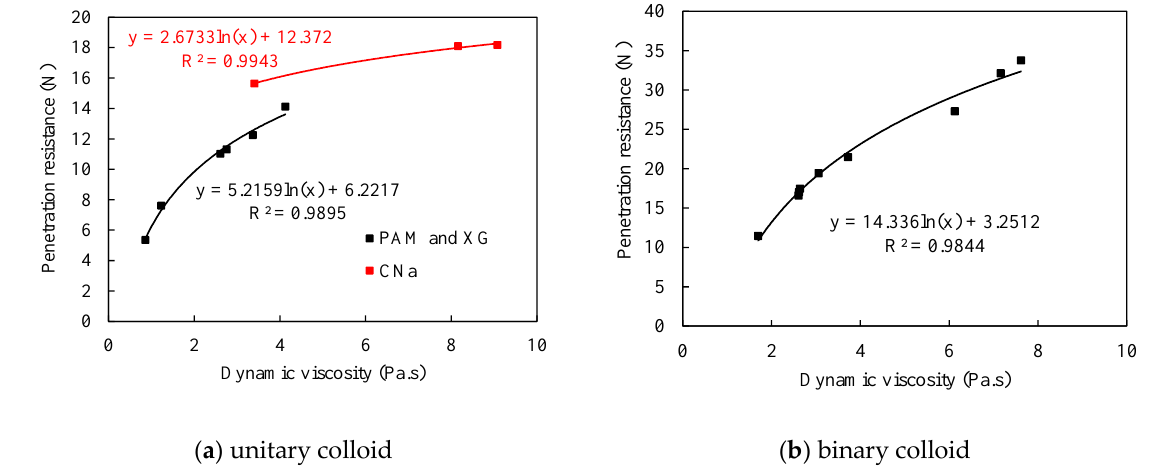
Figure 12. Penetration resistance vs. dynamic viscosity during multivariate aging.